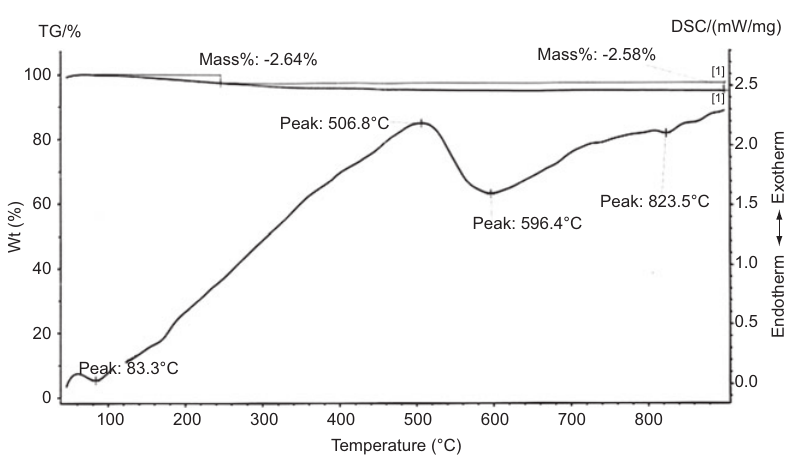
Figure 5 TG-DSC curves of silica-coated HAP.